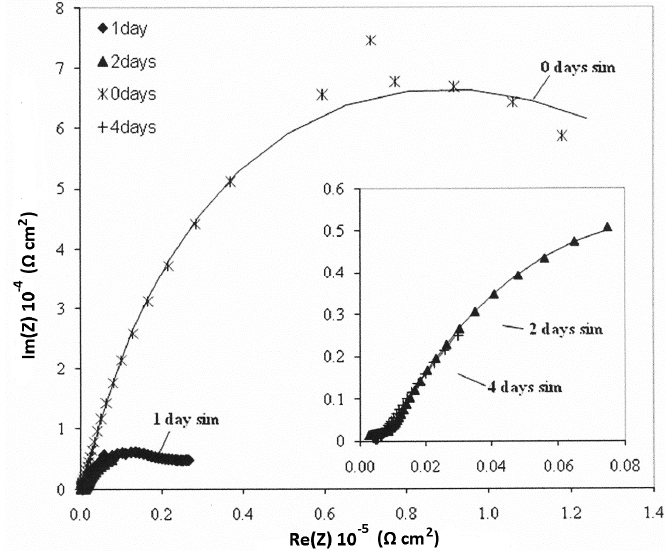
Figure 14. Nyquist plots of impedance spectra, R e (Z), real part of impedance, and I m (Z), imaginary part of impedance, for I.30 nanocomposite coated specimens after 0, 1, 2, or 4 days of exposure in a corrosive environment of 3.5 wt % NaCl solution.